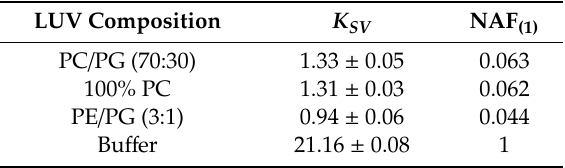
Figure 7. Steady-state fluorescence anisotropy relative to 1,6-Diphenyl-1,3,5-hexatriene (DPH)-containing LUVs, upon interaction with Trematocine. Anisotropy was normalized for each experiment with the r 0 relative to DPH-containing LUVs in the absence of the peptide.